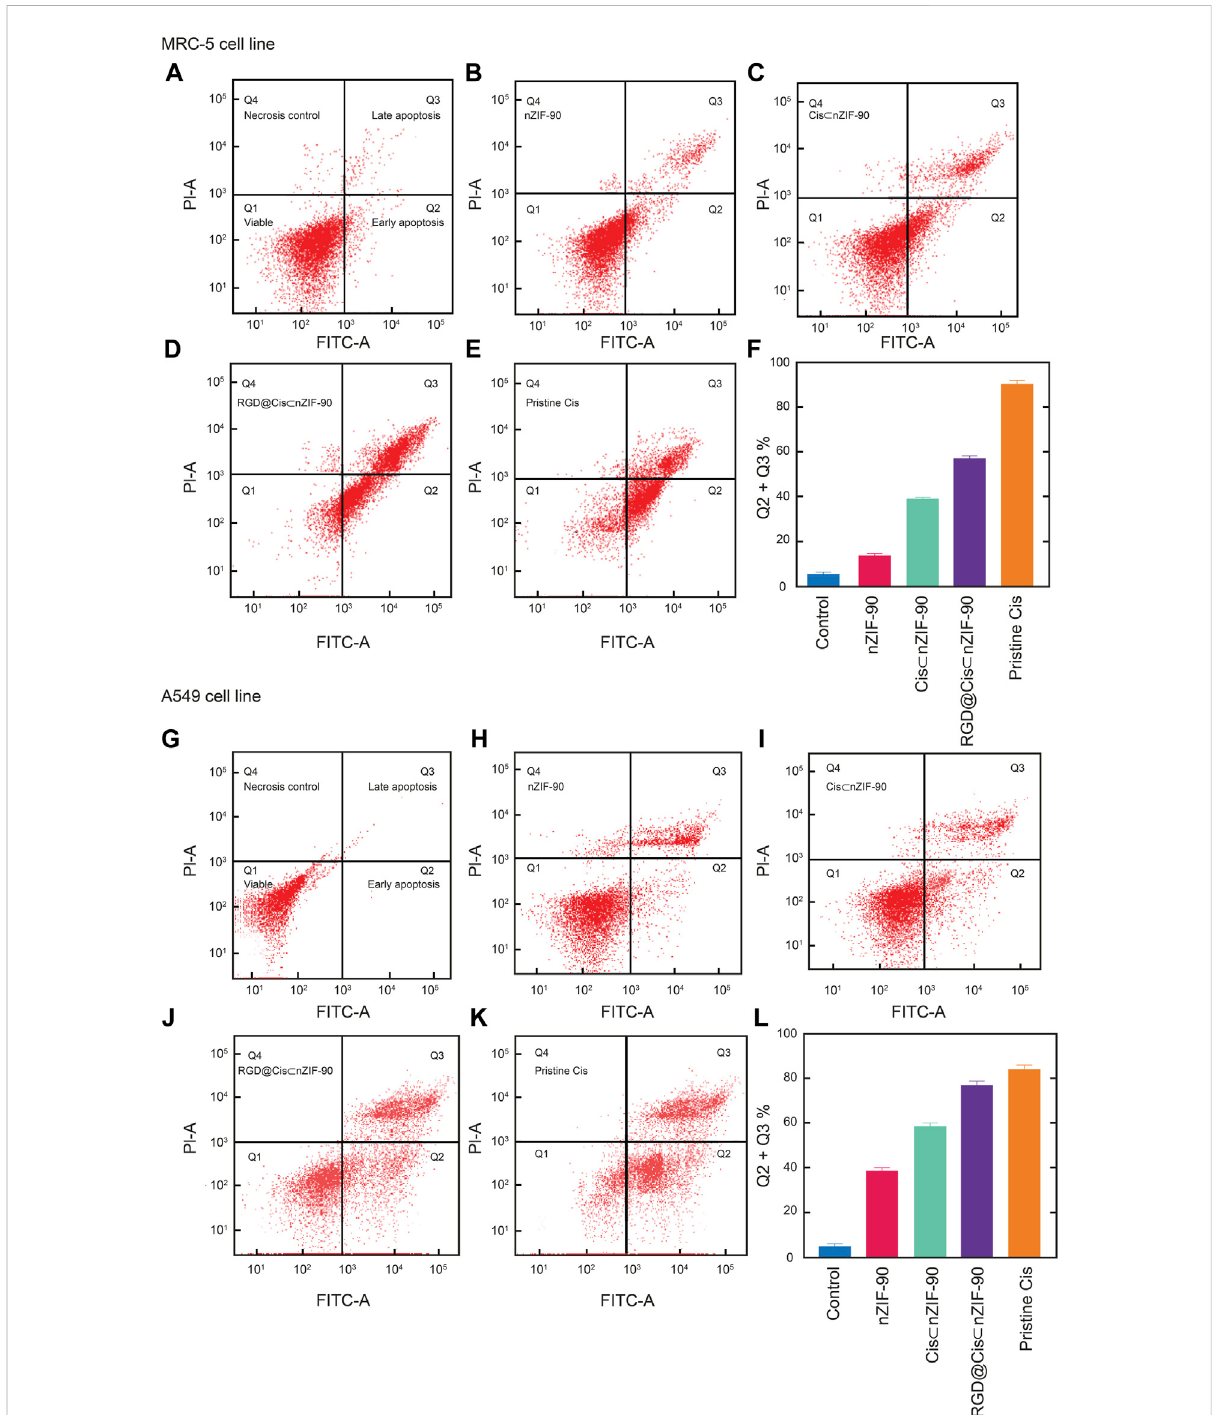
FIGURE 6 Apoptoticcellpopulationobtained by fl owcytometryanalysis aspresented usingreddotplotsofMRC-5cells (A – F) andA549 cells (G – L) .After 48 h of treatment with the appropriate 50% inhibiting concentration (IC 50 value) of nZIF-90, Cis ⊂ nZIF-90, RGD@Cis ⊂ nZIF-90 and Cis. The plots (A) and (G) show the control. A graphical representation of the total percentage of apoptotic cells for each is provided in (F) and (L) . The fl uorescence intensity of Annexin V FITC and PI are used to identify Q 1 as healthy cells (double negative), Q 2 as early apoptotic (Annexin V positive), Q 3 as late